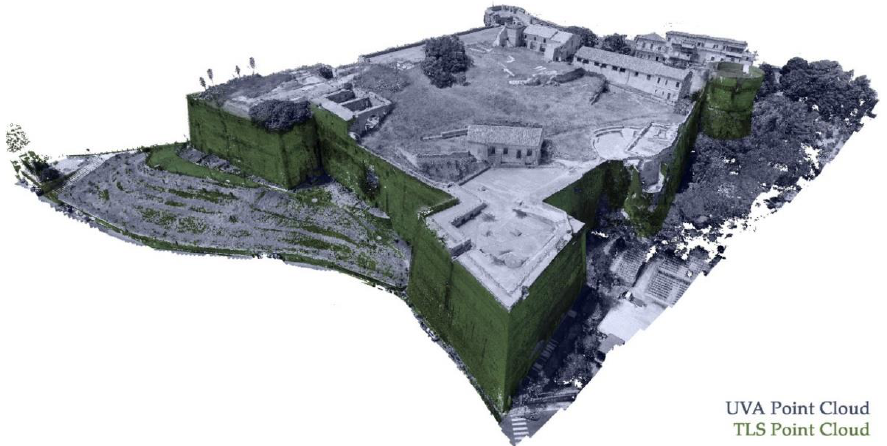
Figure 6. Integrated TLS (green) and UAV (violet) point clouds.